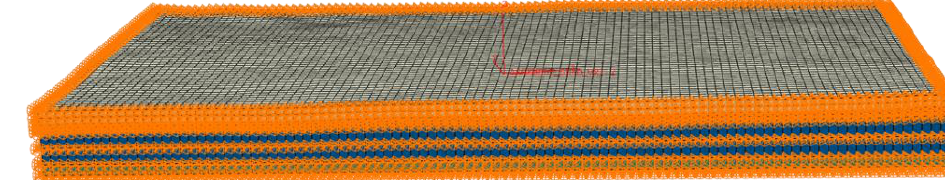
Figure 5. The mesh of the finite element model .